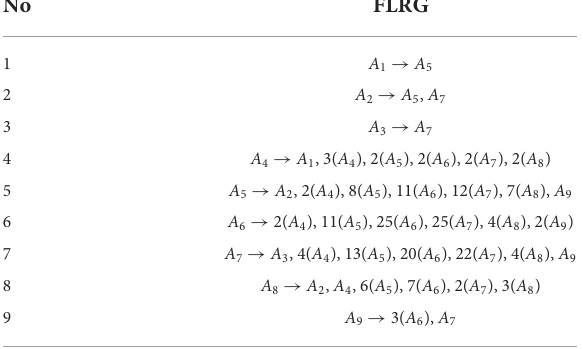
TABLE 8 The fuzzy logic relation group (FLRG). TABLE 9 The fuzzy logic relation group